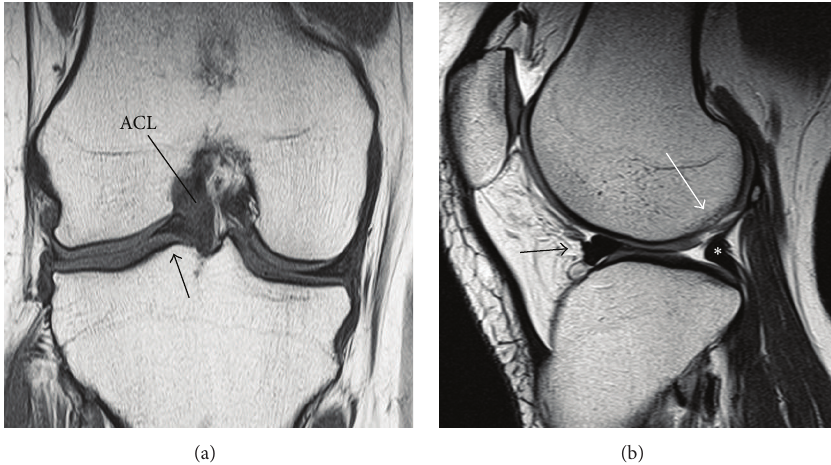
Figure 1: Magnetic resonance imaging of the right knee joint. (a) T1-weighted coronal image showing the posterior segment of the lateral meniscus dislocated into the intercondylar space. The arrow indicates the dislocated posterior segment, which is adjacent to the anterior cruciate ligament (ACL). (b) T2-weighted sagittal image of the lateral compartment depicting the middle segment of the lateral meniscus flipped onto the anterior segment, producing the flipped meniscus sign (black arrow). The popliteus tendon is located on the tibial plateau (asterisk) and displays a similar appearance to the posterior segment of the lateral meniscus. The white arrow indicates an osteochondral defect on the lateral femoral